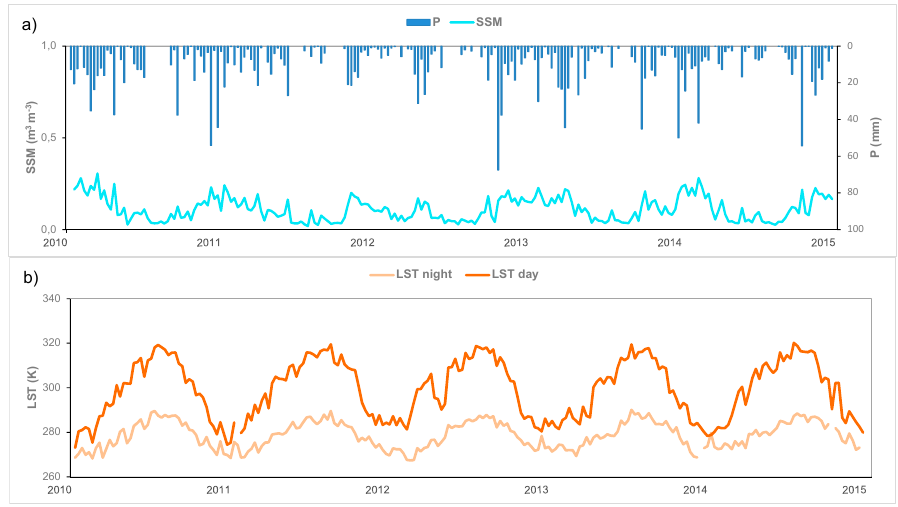
Figure 2. Cont. Figure 2.